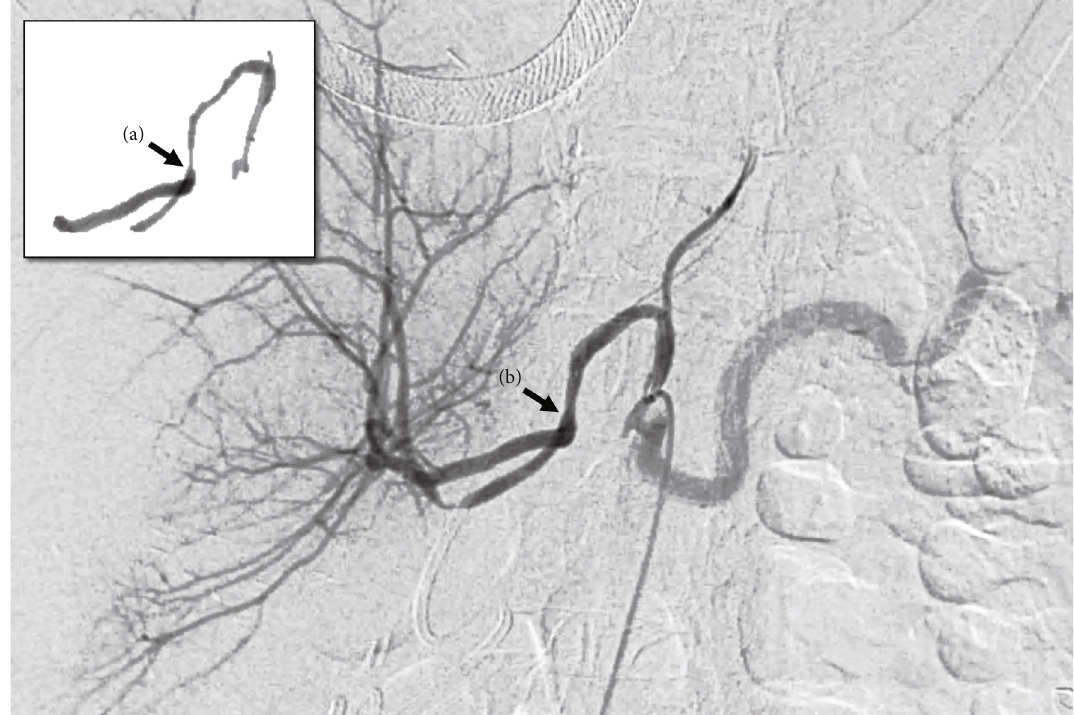
Figure 3: Case 1 celiac angiogram on postoperative day 38. The arrow points to the long segment arterial stenosis preangioplasty (a) and after successful balloon angioplasty